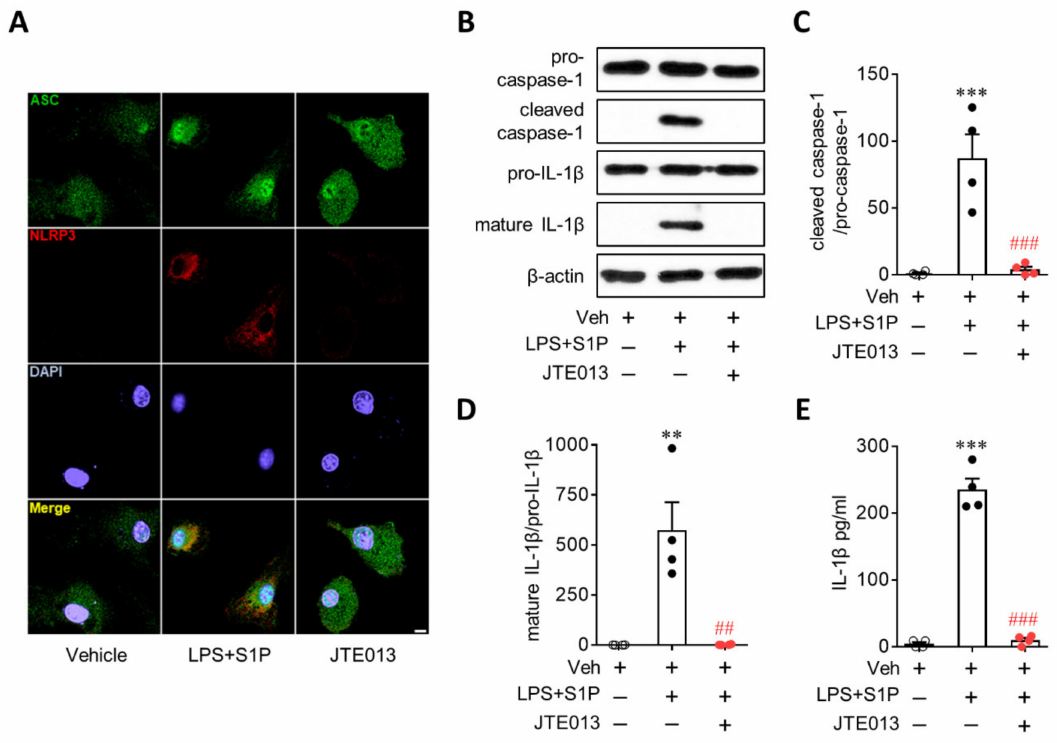
Figure 4. JTE013 treatment attenuates S1P-induced NLRP3 inflammasome activation in LPS-primed BMDMs. Cells were pretreated with JTE013 (10 µ M) for 30 min. Cells were then primed with LPS (500 ng/mL) for 4 h and exposed to S1P (1 µ M) for 1 h. ( A ) Effects of JTE013 on ASC speck formation were determined by double immunofluorescence for ASC (green)